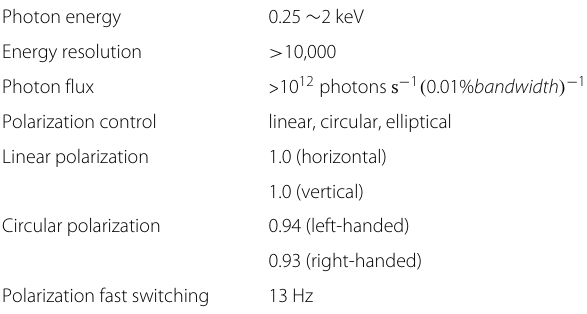
Table 1 Optical parameters at SPring-8